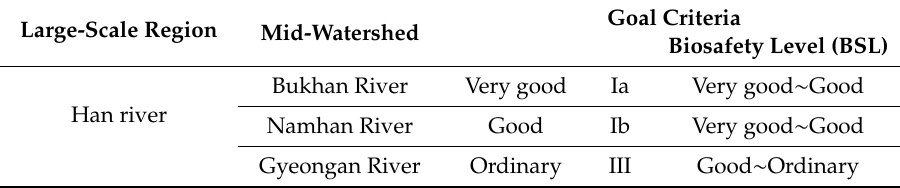
Table 4. The target water quality standard by mid-watershed.